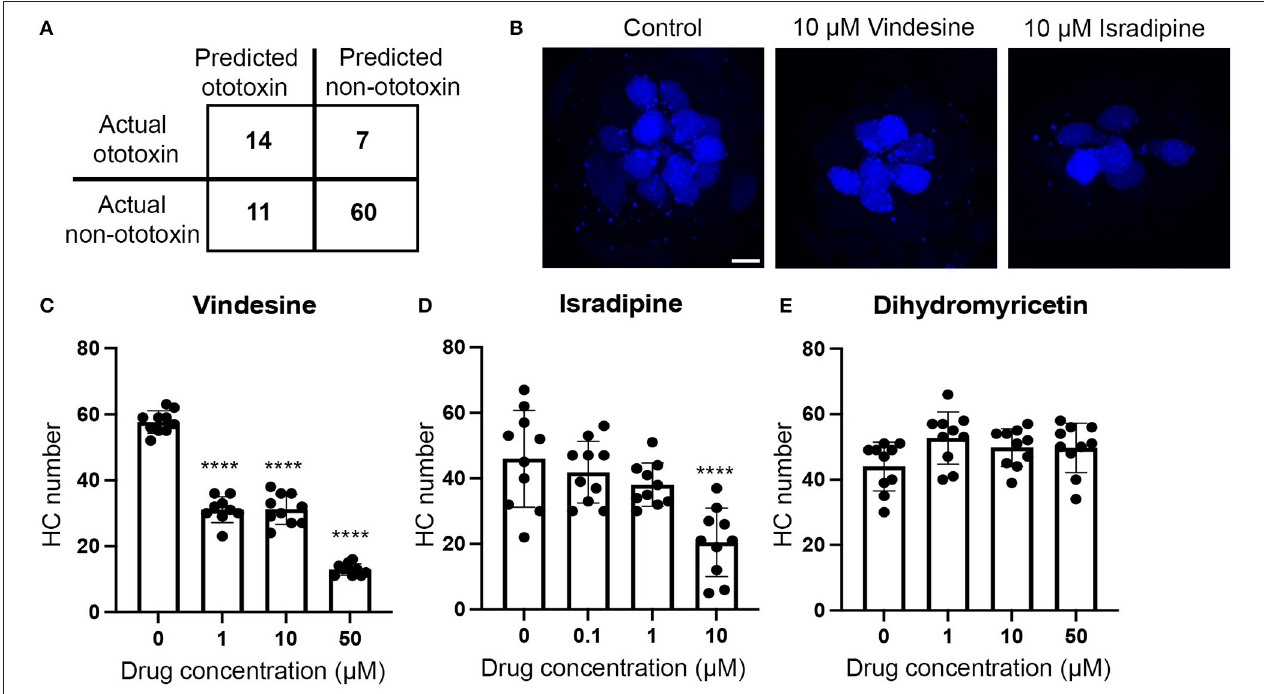
FIGURE 2 | Illustration of how computational and experimental approaches can be combined to identify new ototoxins. (A) Confusion matrix output demonstrating accuracy of our Tanimoto-based algorithm. We used 70% of our ototoxin database to train the model and 30% of our database as probe structures to test accuracy. The model correctly predicted 14 of 21 ototoxins (66%) in the probe test set and 60 of 71 non-ototoxins (84%) for an average accuracy of 75%. (B–E) We then used our model to predict ototoxicity from the PubChem database of ∼ 10,000 ototoxins and validated predicted ototoxins in vivo in the zebrafish lateral line. (B) Vindesine and isradipine are toxic to lateral line hair cells. Confocal images show the M2 neuromast from fish treated for 24h with DMSO (vehicle control, left), 10 µ M vindesine (middle), or 10 µ M isradipine (right). Hair cells were live-labeled with DAPI. The scale bar on the left panel = 5 µ m and applies to all images. (C–E) Quantification of hair cell numbers in five head neuromasts per fish. Numbers were summed to arrive at one value per animal. (C) Vindesine significantly damages hair cells at all concentrations tested [One-way ANOVA, F (3, 35) = 268.4, p < 0.0001]. (D) Isradipine also caused significant hair cell loss [ F (3, 36) = 10.97, p < 0.0001]. 50 µ M isradipine was toxic to fish (data not shown). (E) Dihydromyricetin did not cause hair cell loss [ F (3, 36) = 2.42, p = 0.07]. Bonferroni-corrected post-hoc tests indicate significant differences from controls **** p < 0.001. N = 9–10 animals per group, data are presented as mean + s.d. and dots represent individual